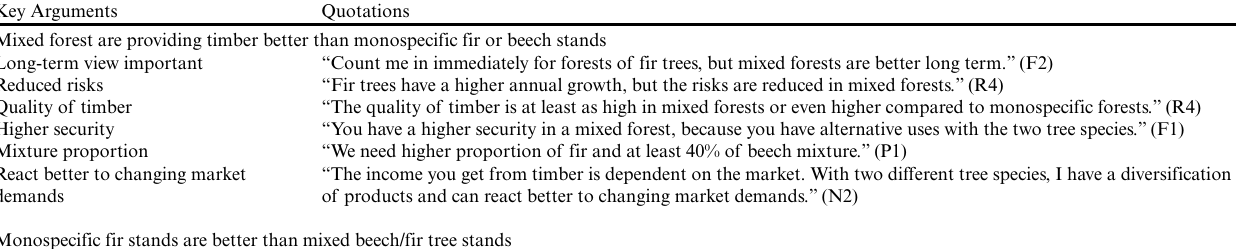
Table 5 . Reasons for selecting mixed fir/beech stands or monospecific stands with a better provision of the prioritized ecosystem services